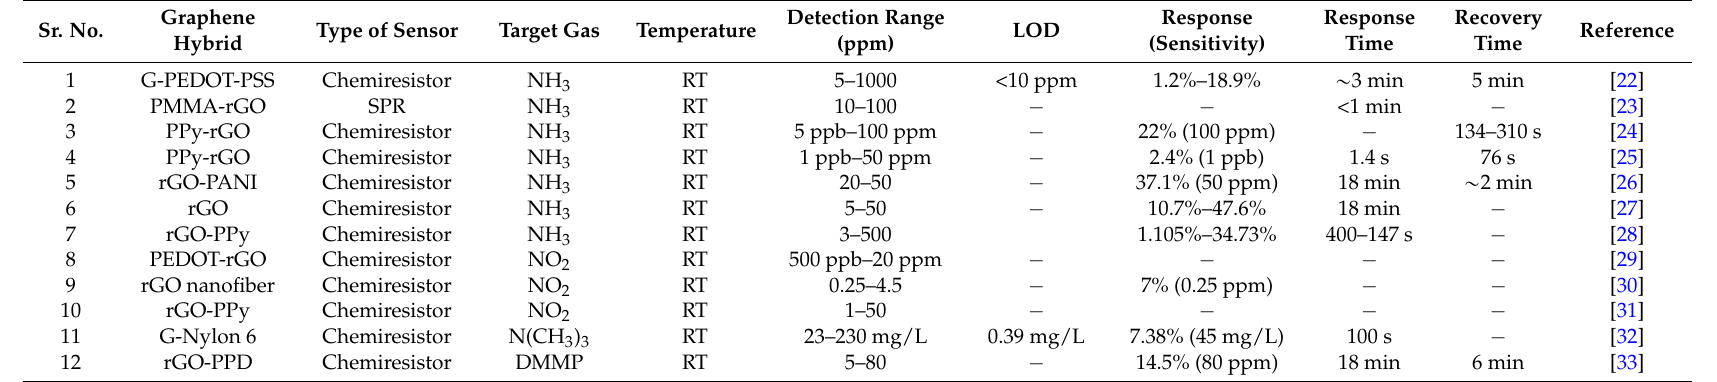
Table 2. Gas sensors based on graphene polymer hybrids. G = Graphene; rGO = reduced grapheme; poly(3,4-ethylenedioxythiophene): poly(styrenesulfonate)(PEDOT:PSS); polypyrrole (PPy); poly(methyl methacrylate) (PMMA); RT = room temperature; PANI = polyaniline; PPD = p-phenylenediamine; DMMP = dimethyl methyl phosphonate. Sr.